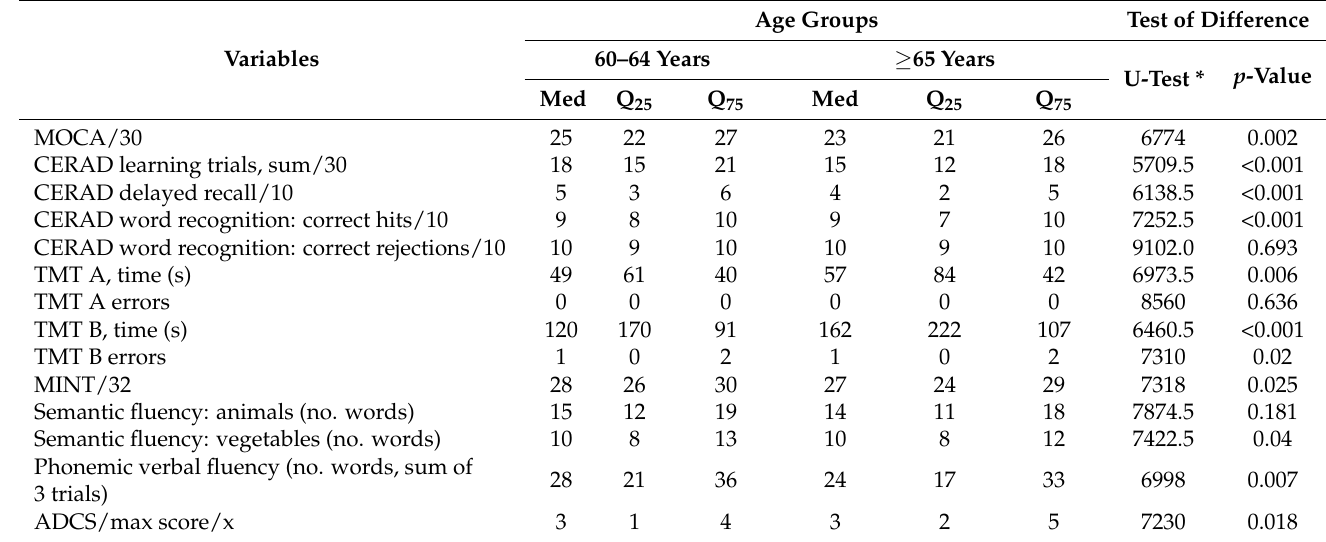
Table 4. Summary statistics for neuropsychological test scores for age groups.